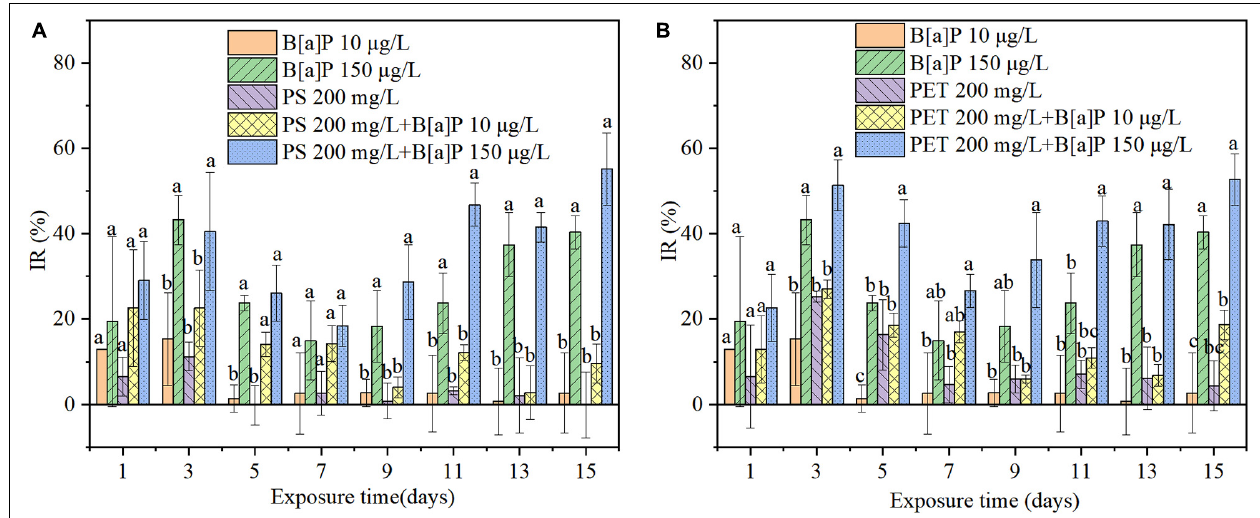
FIGURE 4 | The single and combined effects of microplastics [ (A) mPS and (B) mPET] and B[a]P on the IR of C. muelleri. Different letters indicate significant differences among treatments ( P < 0.05).